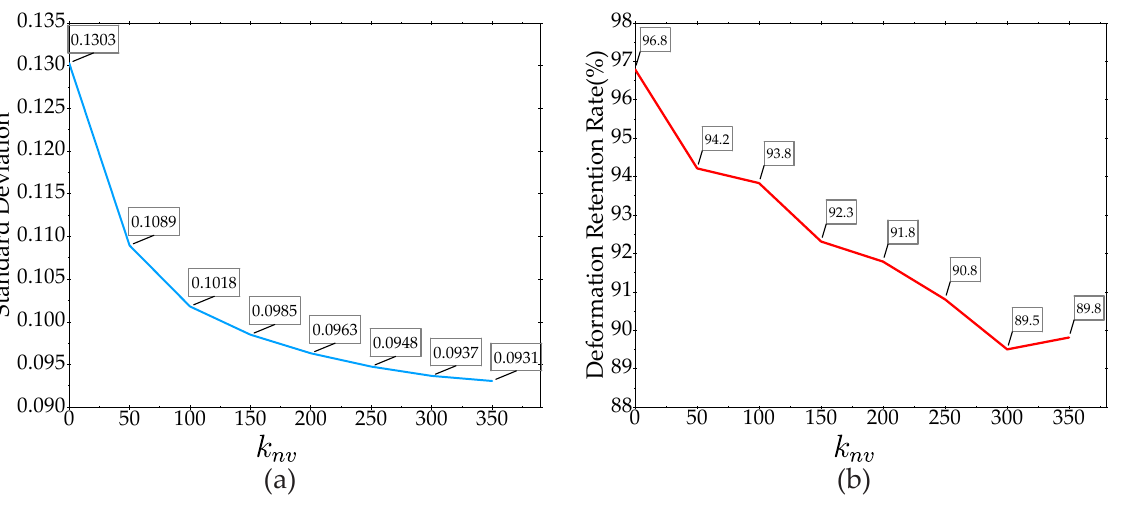
Figure 21. The mean value curve of standard deviation and DRR curves when k ph = 50, k cl = 10: ( a ) mean value curves of standard deviation, ( b ) DRR